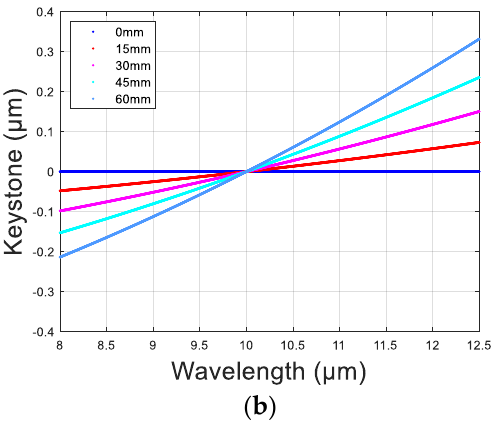
Figure 9. Smile and Keystone. ( a ) Smile; ( b ) Keystone.